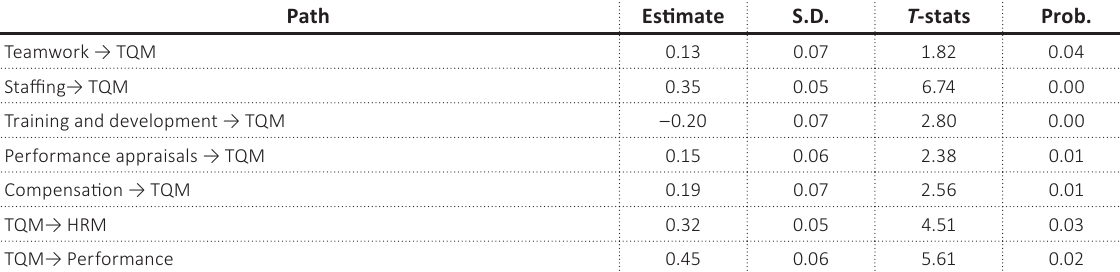
Table 5. Path analysis